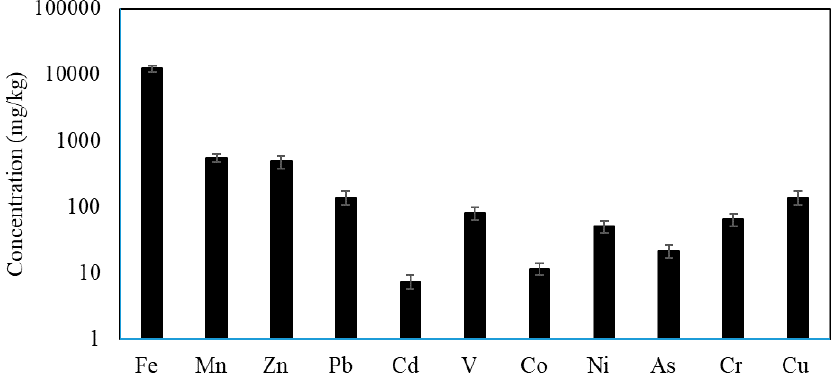
Figure 2. Average heavy metals concentrations in the urban road dusts of Jeddah.